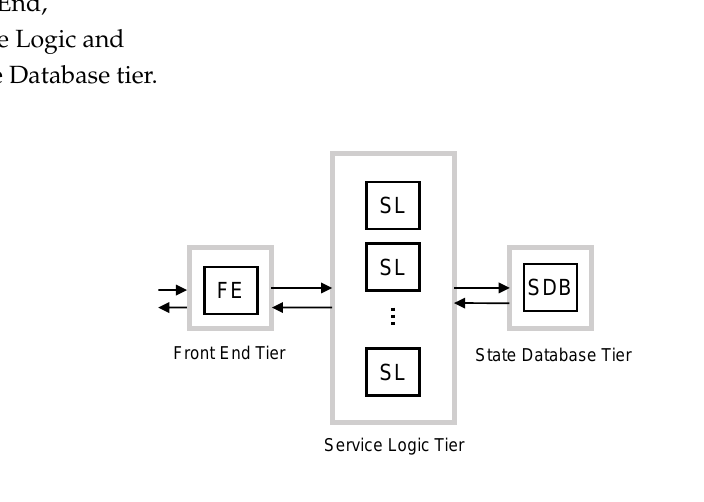
Figure 6. Baseline scheme block